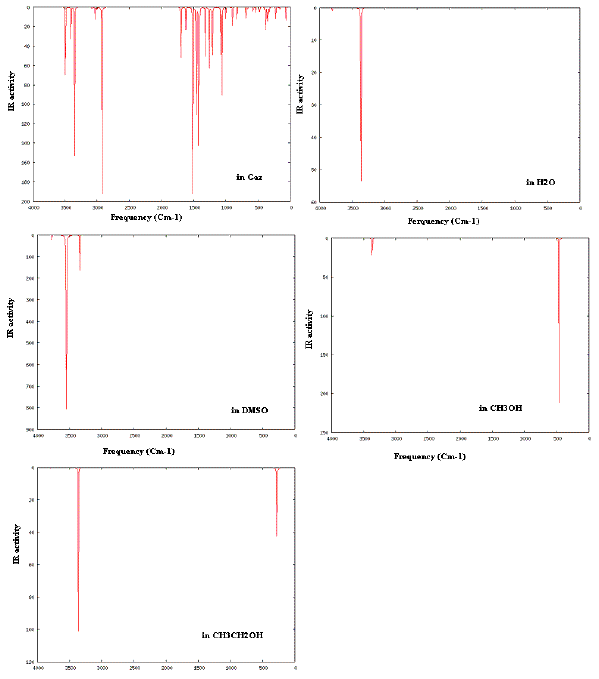
Figure 2. Simulate the IR spectra for the most stable state (V isomer in Fig. 1) in different solvents. IR spectrum scaled by